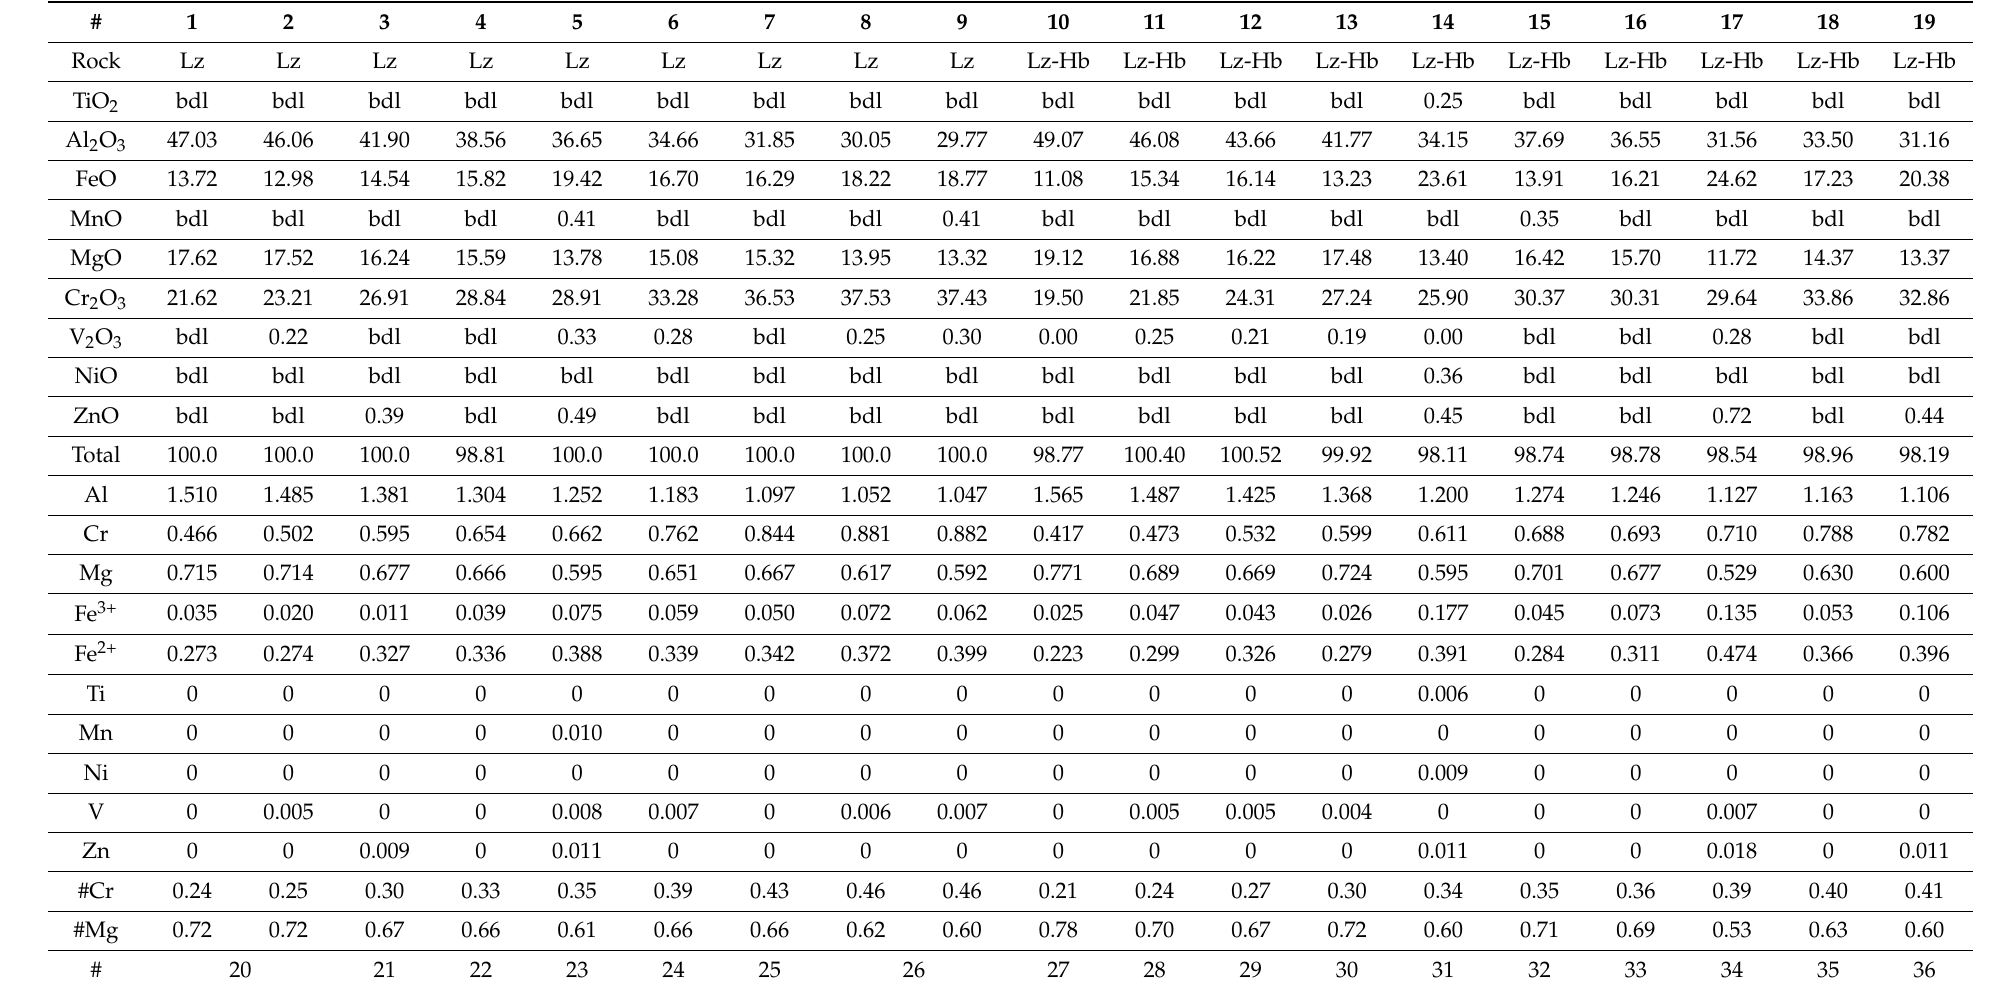
Table 6. Composition of Cr-spinel grains in peridotite of Kempirsay massif